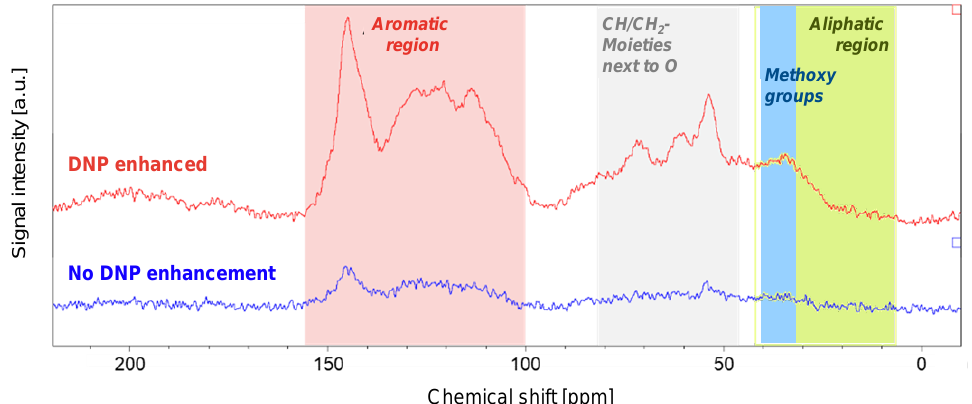
Figure 6. 1 H- 13 C CP-MAS spectra of kraft lignin recorded with DNP enhancement (red, top ) and without DNP enhancement (blue, bottom ); spectra were recorded with the same number of scans (512 scans).